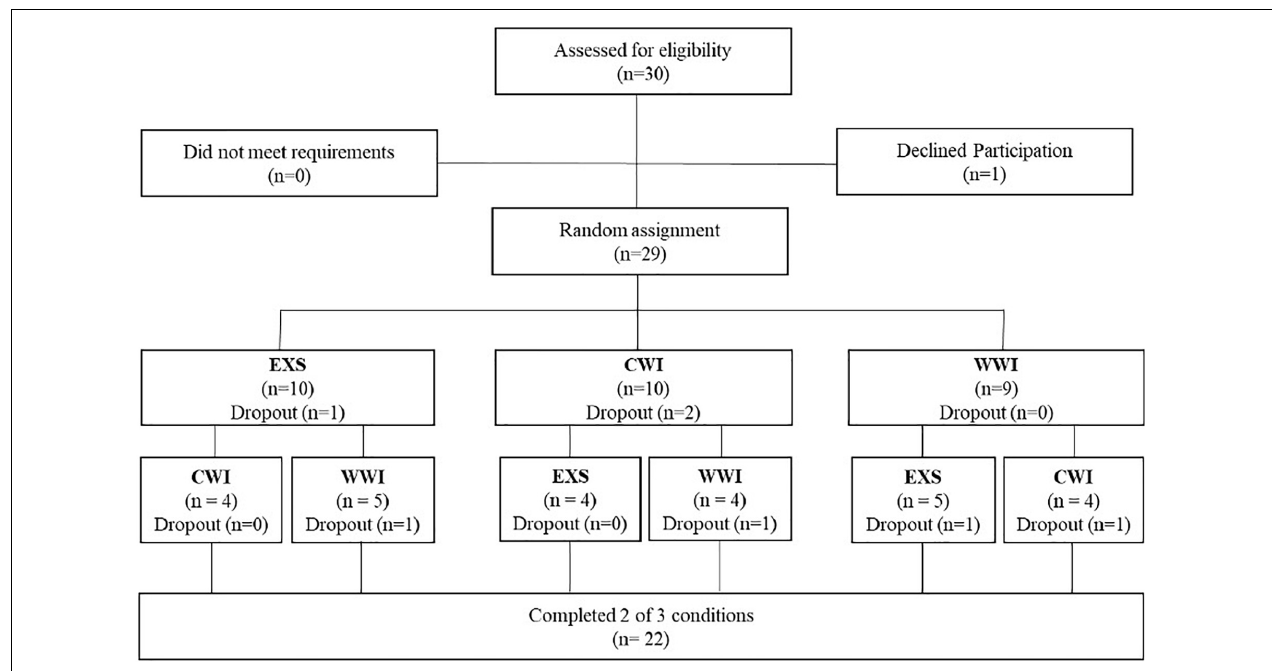
FIGURE 2 | Study flow diagram. Partial randomized crossover trial where participants completed two of three training interventions (each 12 training sessions); 60 min of continuous exercise or 30 min of exercise followed by either 30 min of warm water ( ∼ 38–40 ◦ C) or cold water ( ∼ 10–12 ◦ C) immersion to the